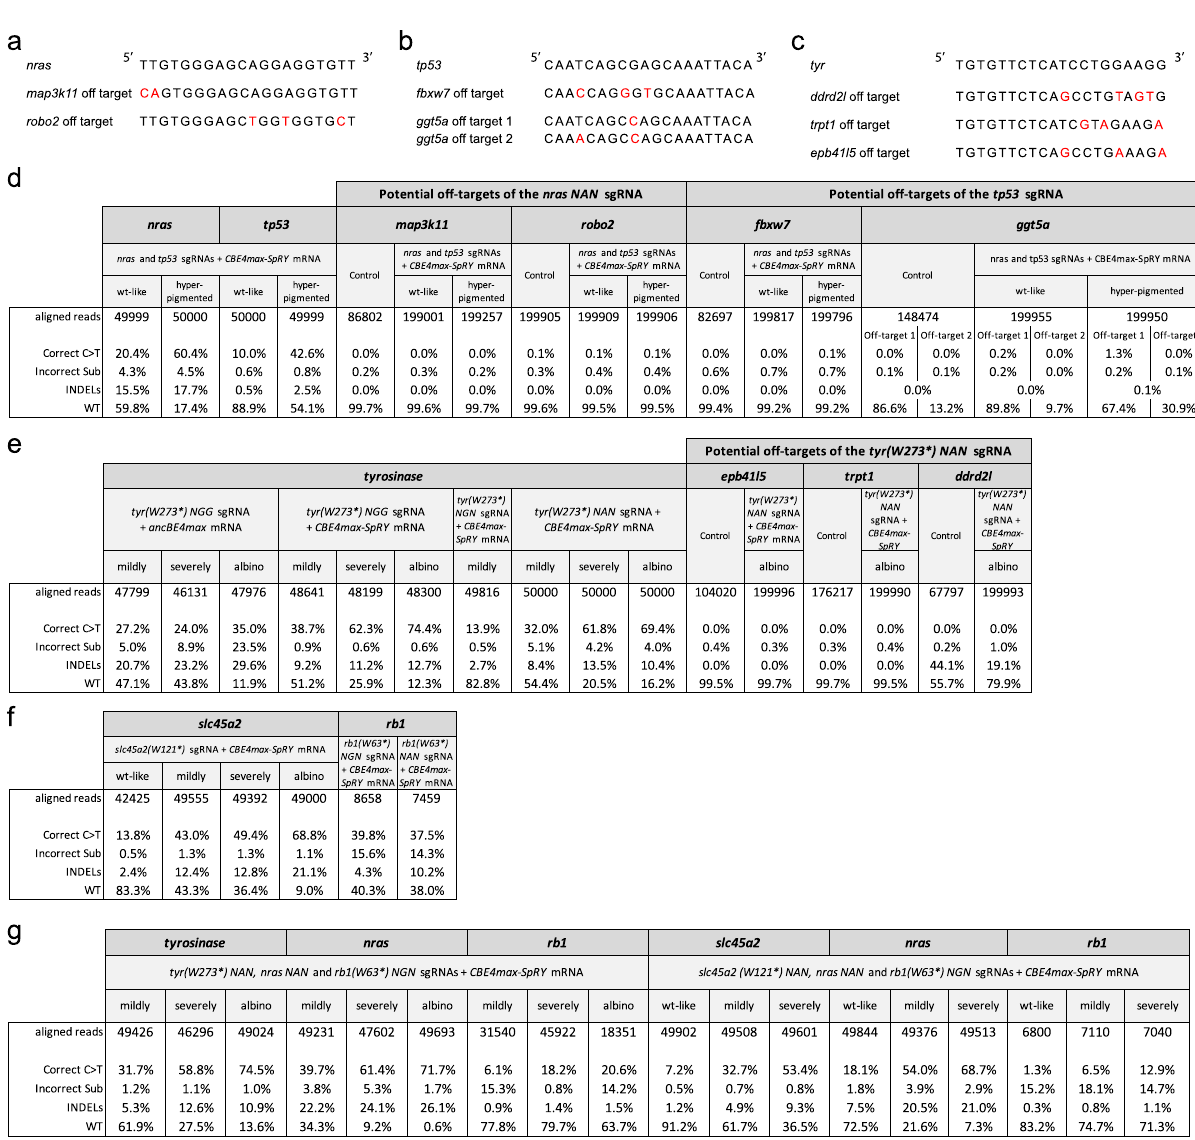
Fig. 5 On-target and potential off-target analyses by NGS sequencing. a – c Potential off-target sequences with mismatches in red of the nras NAN sgRNA ( a ), tp53 sgRNA ( b ), and tyr(W273*) NAN sgRNA ( c ). d – g NGS sequencing was made on pools of embryos with at least 6800 analyzed reads for